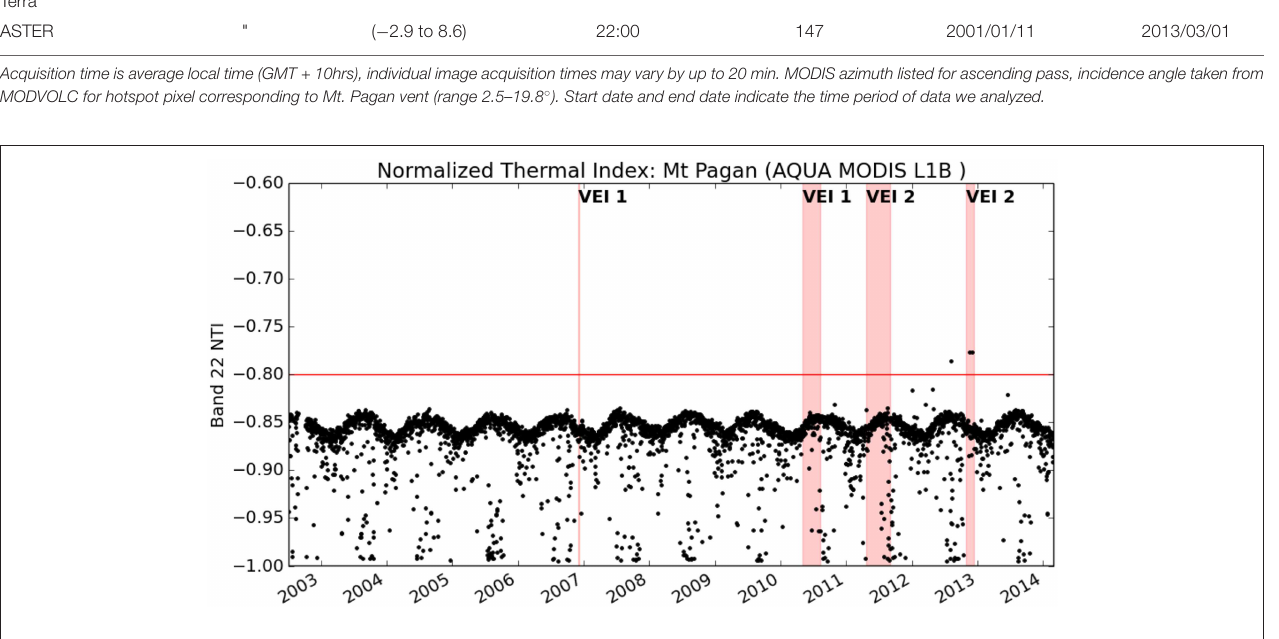
FIGURE 4 | Normalized Thermal Index derived from MODIS Level 1B (MYD021KM), based on the MODVOLC algorithm utilizing band 22 (3.939–3.989 µ m) (Wright, 2004 ). Black dots correspond to maximum NTI values for pixels on Pagan Island, which almost always correspond to the summit crater vent. A clear seasonal signal is visible, as well as anomalous high values during some dates in 2011-2014. Vertical red bars represent spans of eruptive activity as reported in Global Volcanism Program (2013) . Horizontal red line indicates alert threshold used in MODVOLC